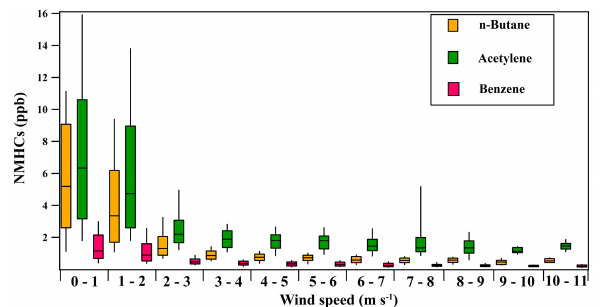
Figure 5. Box plots for (a) n- butane, (b) acetylene and (c) ben- zene relative to wind speed for the period from 16 October 2015 to 15 February 2016. The black lines represent the median value and the boxes show the interquartile range. The bottoms and the tops of the boxes depict the respective first and third quartiles (i.e., Q1 and Q3). The whiskers correspond to the first and the ninth deciles (i.e., D1 and D9). The range of each wind speed bin is depicted on the x axis.